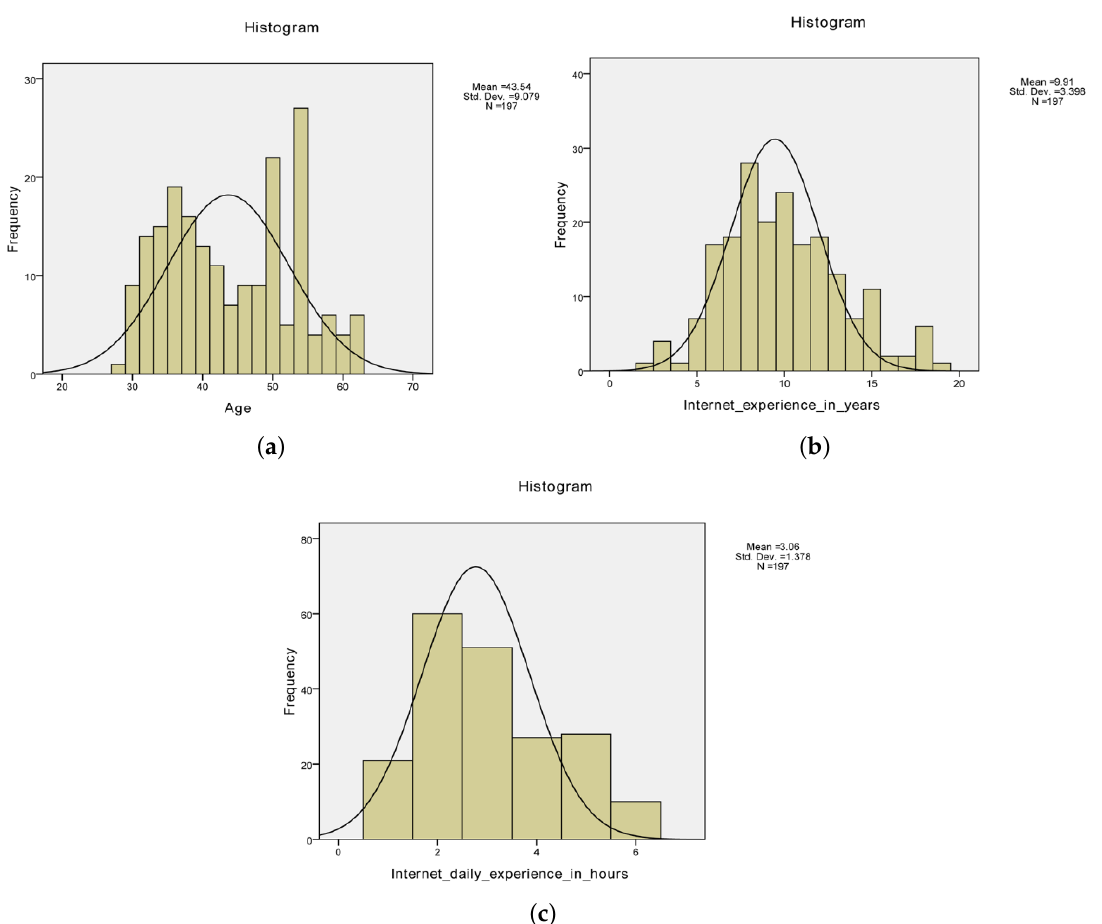
Figure 2. Distribution of: ( a ) users’ age; ( b ) Internet experience in number of years; and ( c ) daily Internet usage in number of